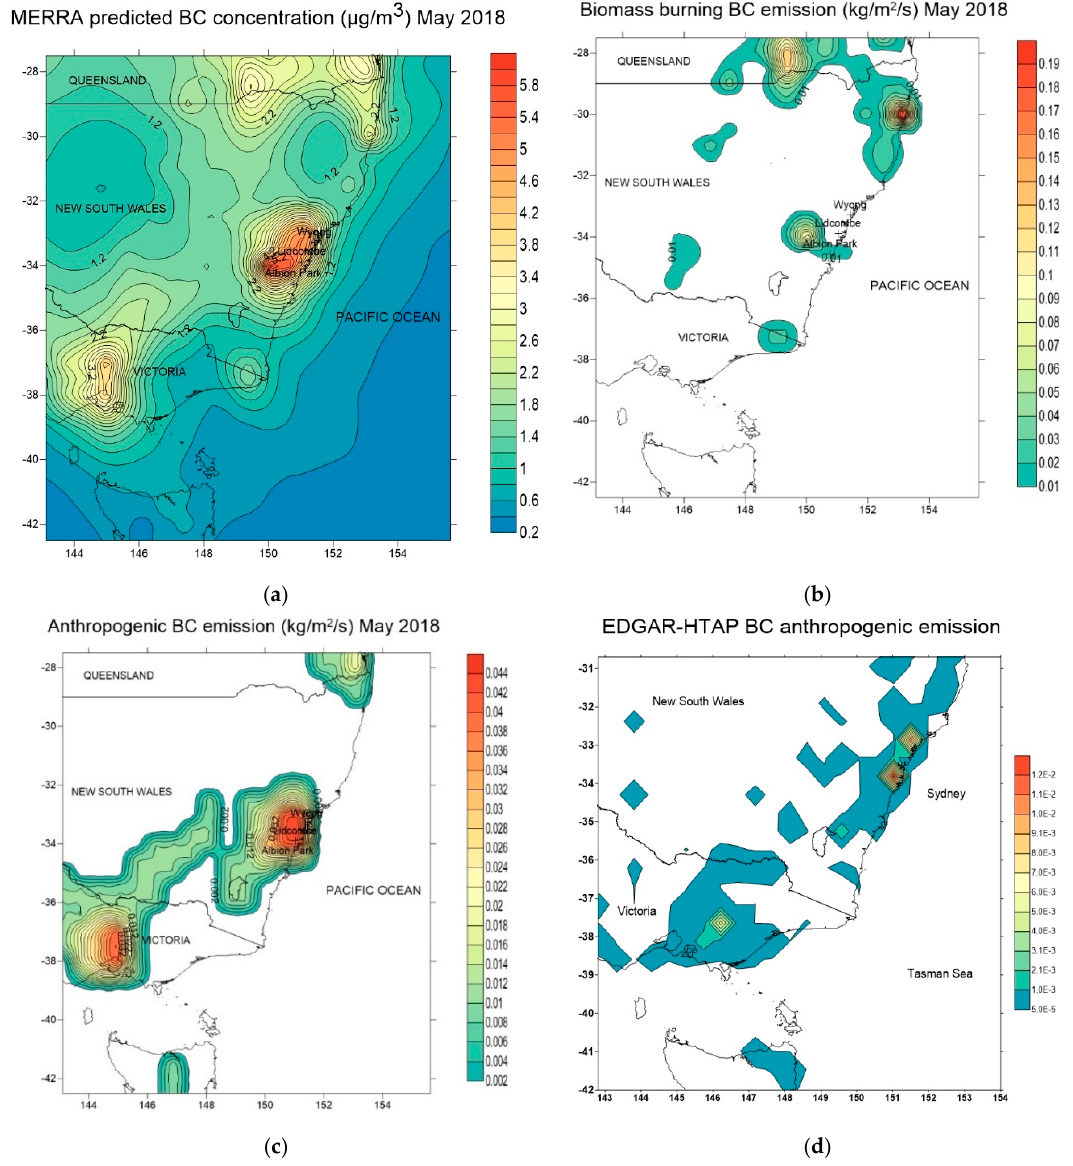
Figure 2. ( a ) BC one-month average surface mass concentration (May 2018); ( b ) BC emission from biomass burning sources; ( c ) BC emission from anthropogenic sources as provided from MERRA-2 of GEOS-5 model; and ( d ) EDGAR-HTAP global anthropogenic black carbon (BC) emission ( μ g/m 3 m/s) at 15 km × 15 km resolution.